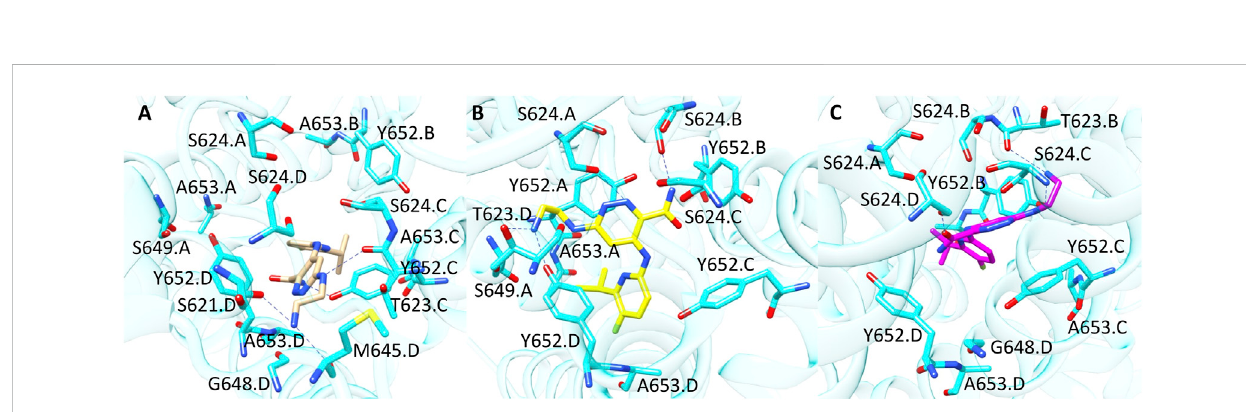
FIGURE 6 Binding modes of compound 8 into hERG binding site predicted by (A) LiGen, (B) PLANTS and (C) GOLD. H-bonds are represented as blue dashed lines.